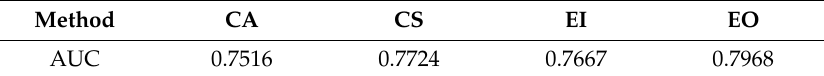
Table 5. AUC values for different